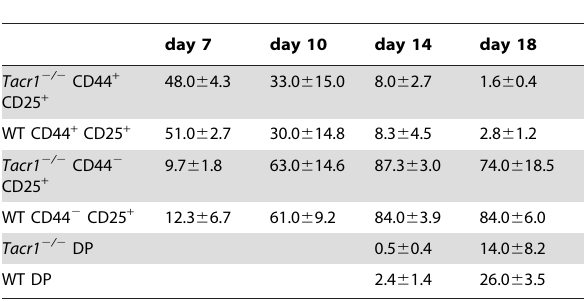
Table 2. T cell development on OP9-DL1